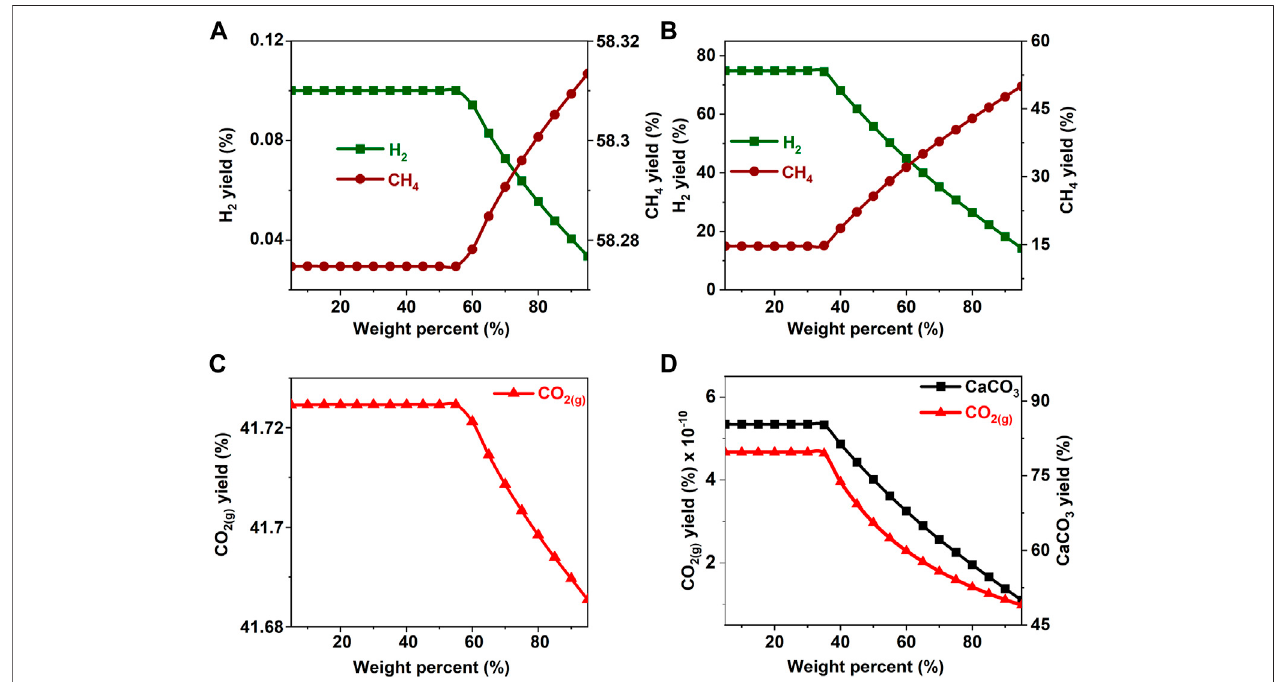
FIGURE 5 | Effect of glycerol concentration on the product yield (A , C) in the absence and (B) in the presence of calcium oxide. The yield of CO 2 post capture to produce calcium carbonate is represented in 3 (D) . These calculations are performed with temperatures of 227 ° C and pressures of 50 bar.